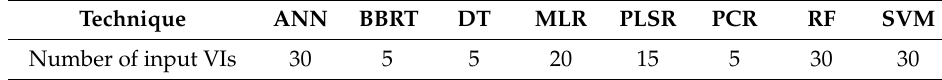
Table 5. Optimal number of input VIs for the eight analytical techniques.